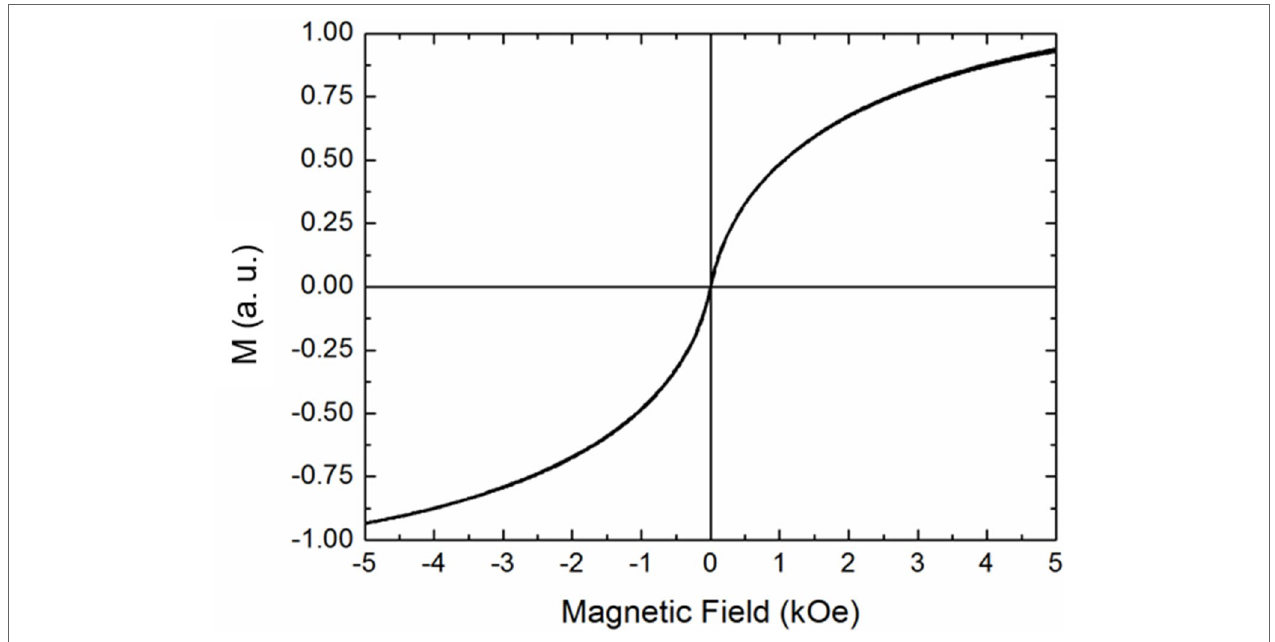
FIGURE 7 | RT magnetization curve for